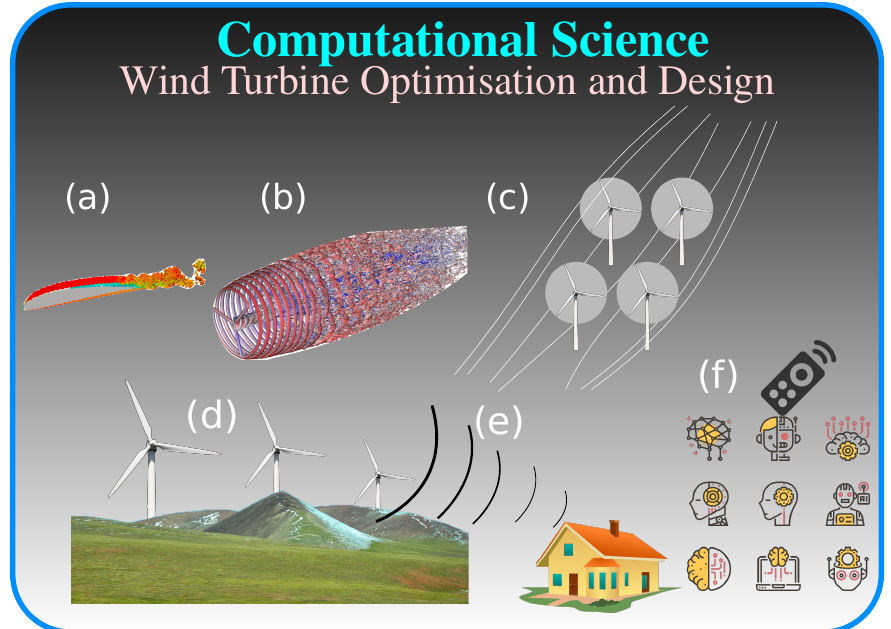
Figure 4. Computational science: Multi-disciplinary design and optimisation of enhanced wind power renewable energy components and systems. ( a ) Aeroelasticity prediction for wind turbine airfoil design; ( b ) detailed fluid flow prediction in a complete stator-rotor system of a wind turbine; ( c ) optimisation of wind turbines’ placement from enhancing wind farm performance; ( d ) forests and urban effect on fluid flow dynamics around a wind farm; ( e ) prediction of aeroacoustic noise emitted from wind farms. ( f ) artificial intelligence (AI) for enhanced automatic monitoring and control.